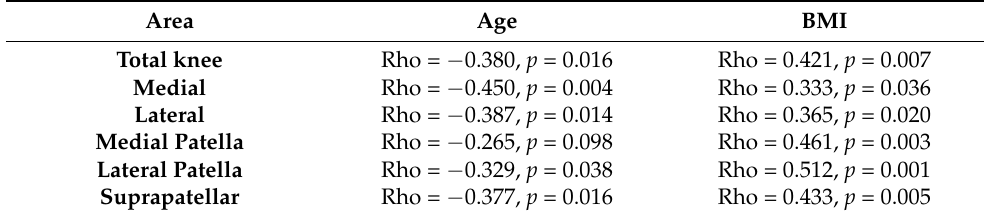
Table 3. Temperature correlates with age and